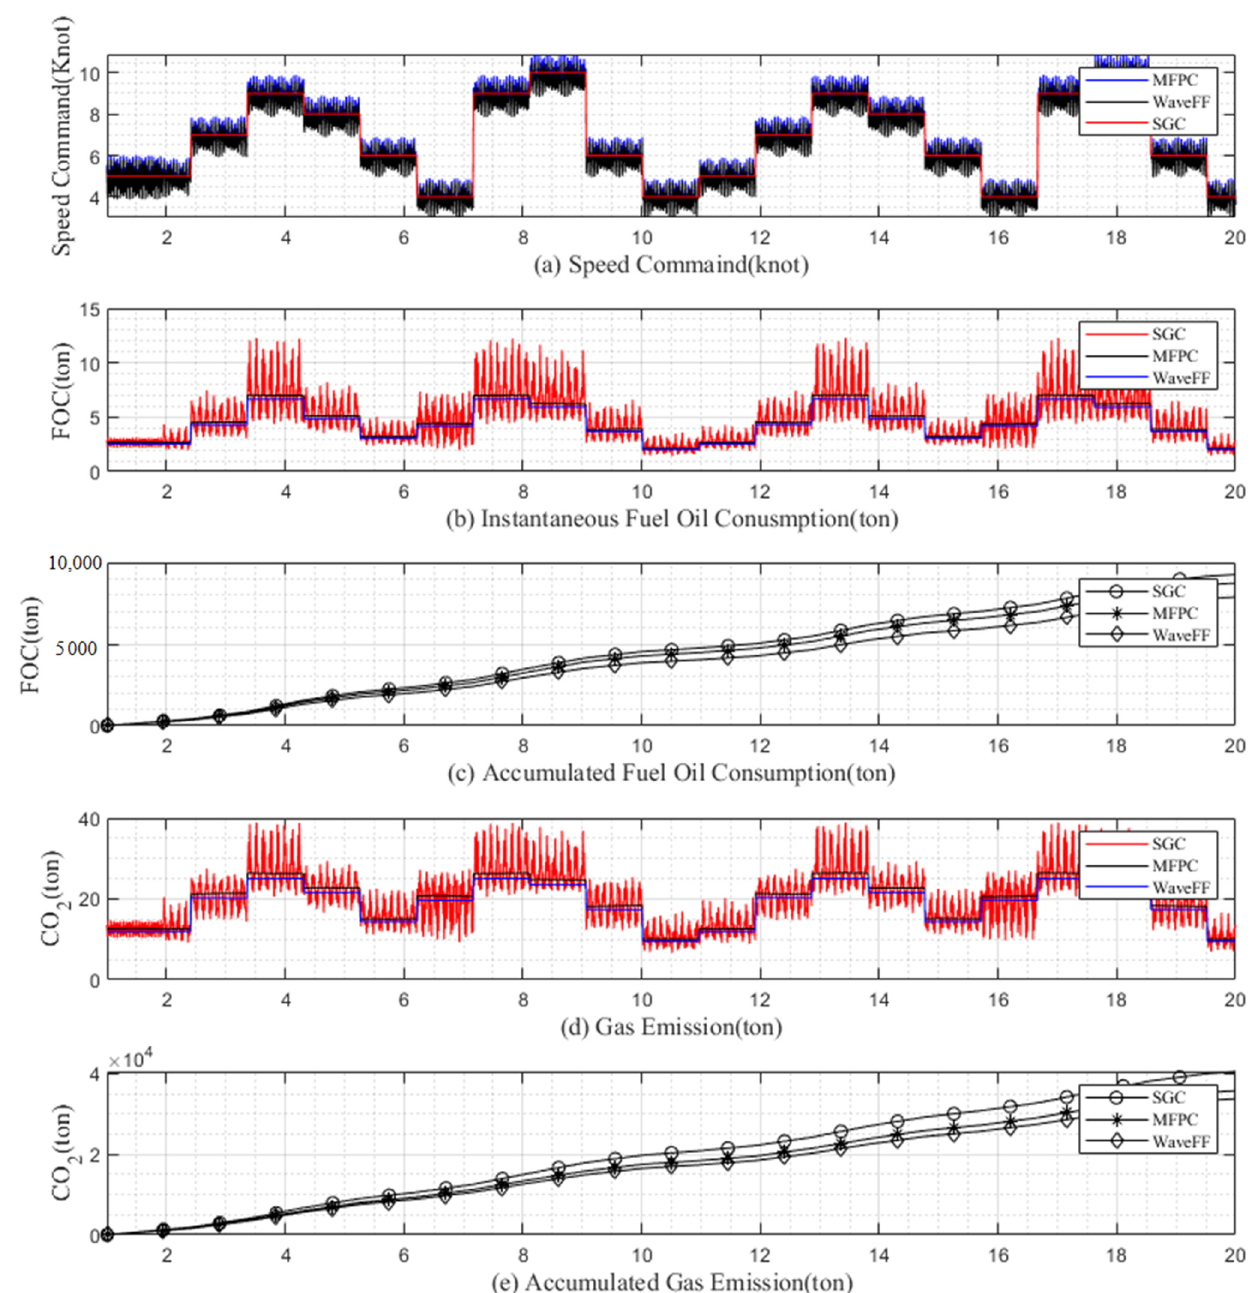
Figure 14. Speed, fuel oil consumption, and gas emission.